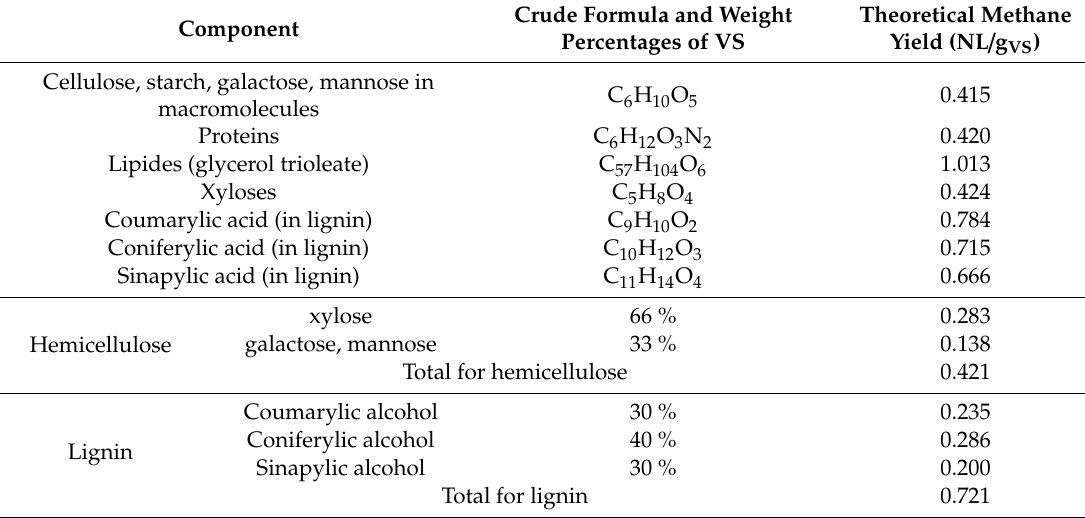
Table A1. Calculation of theoretical methane productivity of organic molecules. Crude Formula and Weight Component Percentages of VS